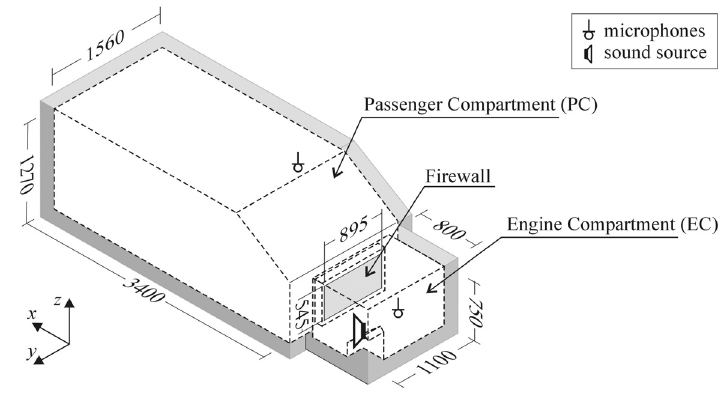
Fig. 1. Schematic view of the system under study (dimensions in